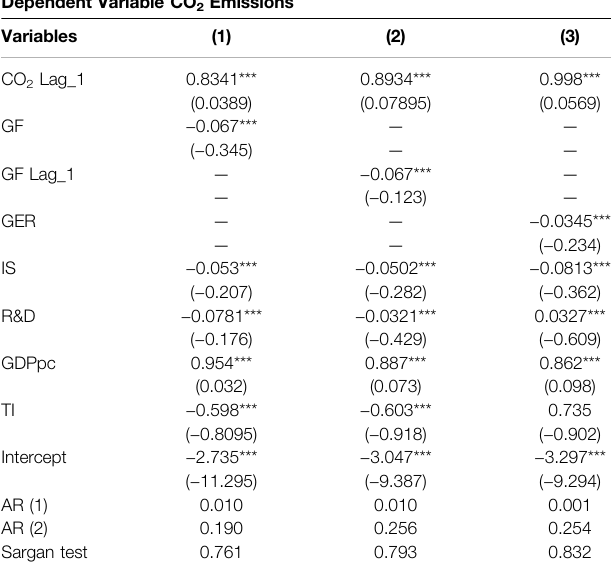
TABLE 3 | Results of System GMM